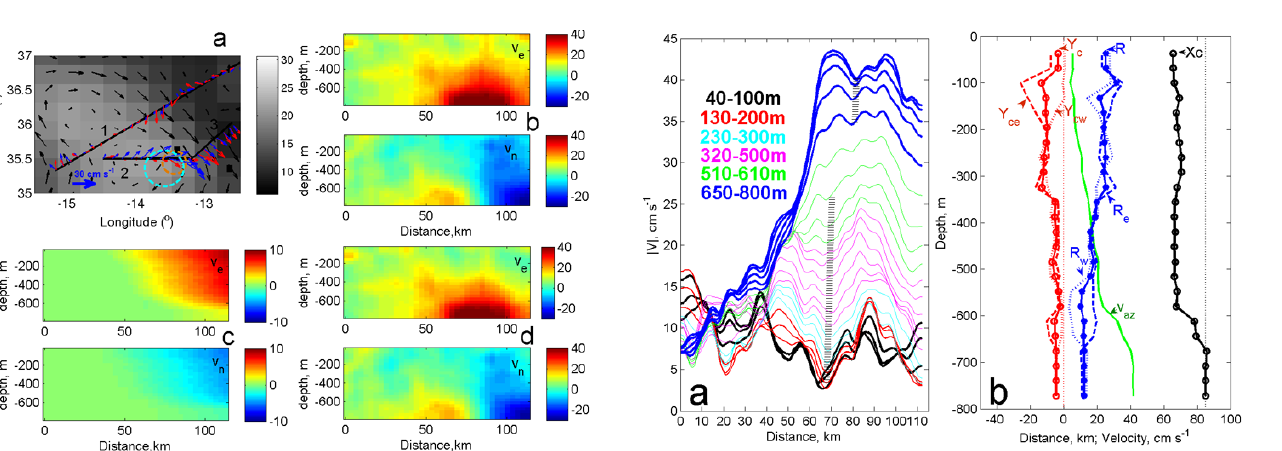
Fig. 2. (a) The sea-level height (cm, colour scale) and AVISO al- timetry currents for 24 August 2010 (black arrows). ADCP currents for 27 Agust 2010 at 100m (red arrows) and at 700m (blue arrows) are also presented. The positions of Meddy 1 and its surface signal, derived from the ADCP data, are presented as orange and cyan cir- cles, respectively. The two black squares mark 2 positions of the vertical profiles of an Argo float where the meddy-like anomaly was registered. (b) East ( V e ) and north ( V n ) velocity components (cms − 1 ) obtained by shipboard ADCP on 27 August 2010 along transect 2. (c) Contribution of the AzC. (d) The same as (b) , but after subtraction of the contribution of the AzC.